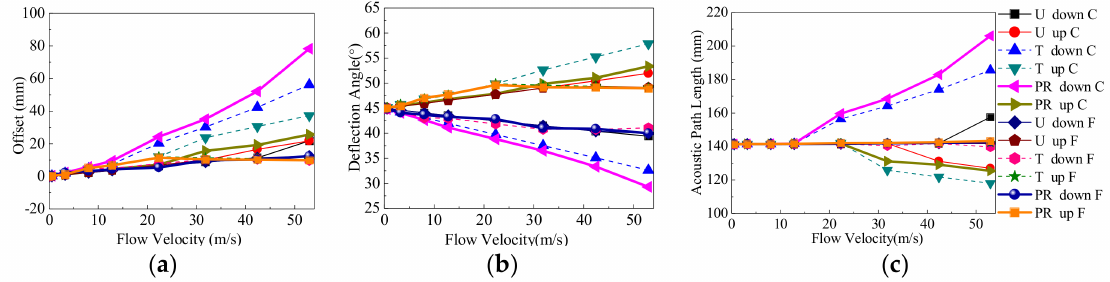
Figure 16. The receiving features of the central and fastest ray in different flow patterns. ( a ) Offset ( ∆ l dC , ∆ l ∆ l ∆ l uF ). ( b ) Deflection angle ( α dC , α uC , α dF , α uF ). ( c ) Length of ray path ( l dC , l uC , l dF , l uF uC , dF ,